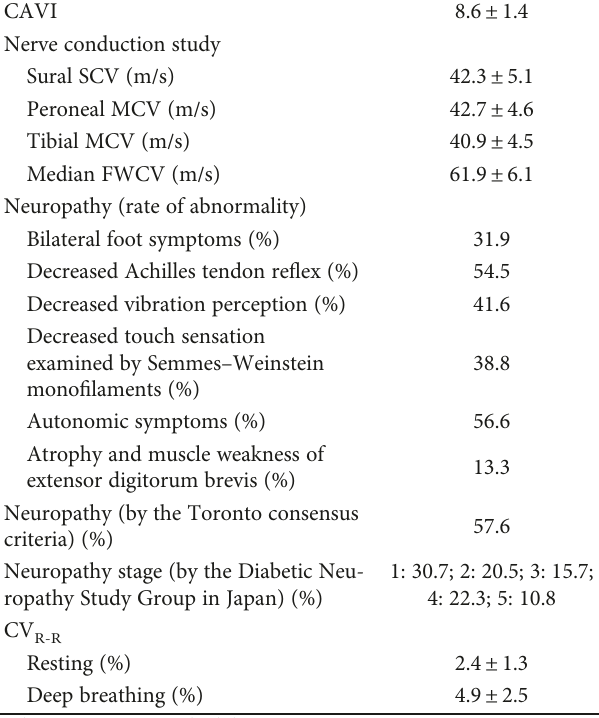
Table 4: Standardized coe ffi cients of multiple linear regression ( β , β ’ ) of all of the explanatory